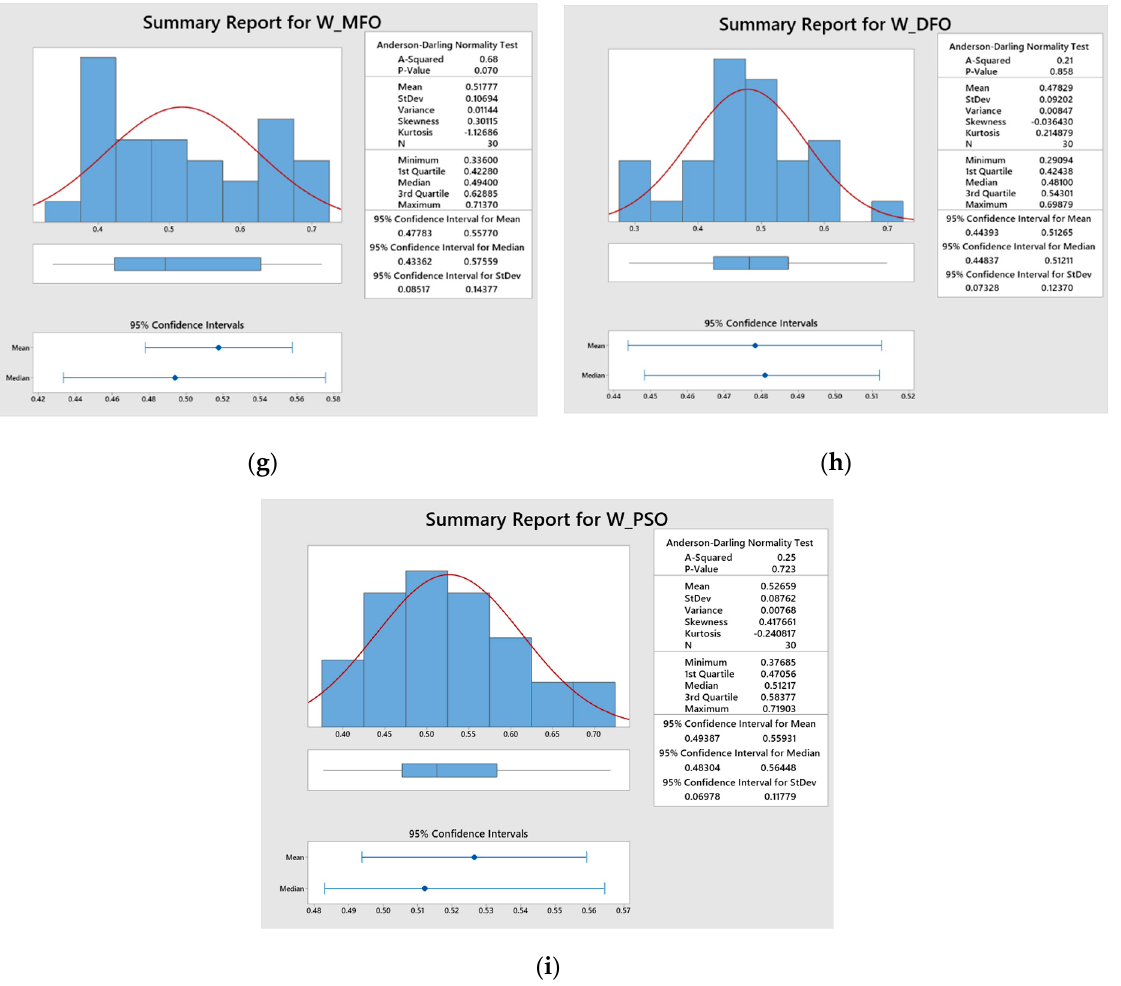
Figure 4. Statistical analysis of closeness values for ( a ) Response L-MFO; ( b ) Response L-DFO; ( c ) Response L-PSO; ( d ) Response D-MFO; ( e ) Response D-DFO; ( f ) Response D-PSO; ( g ) Response W-MFO; ( h ) Response W-DFO; ( i ) Response W-PSO.